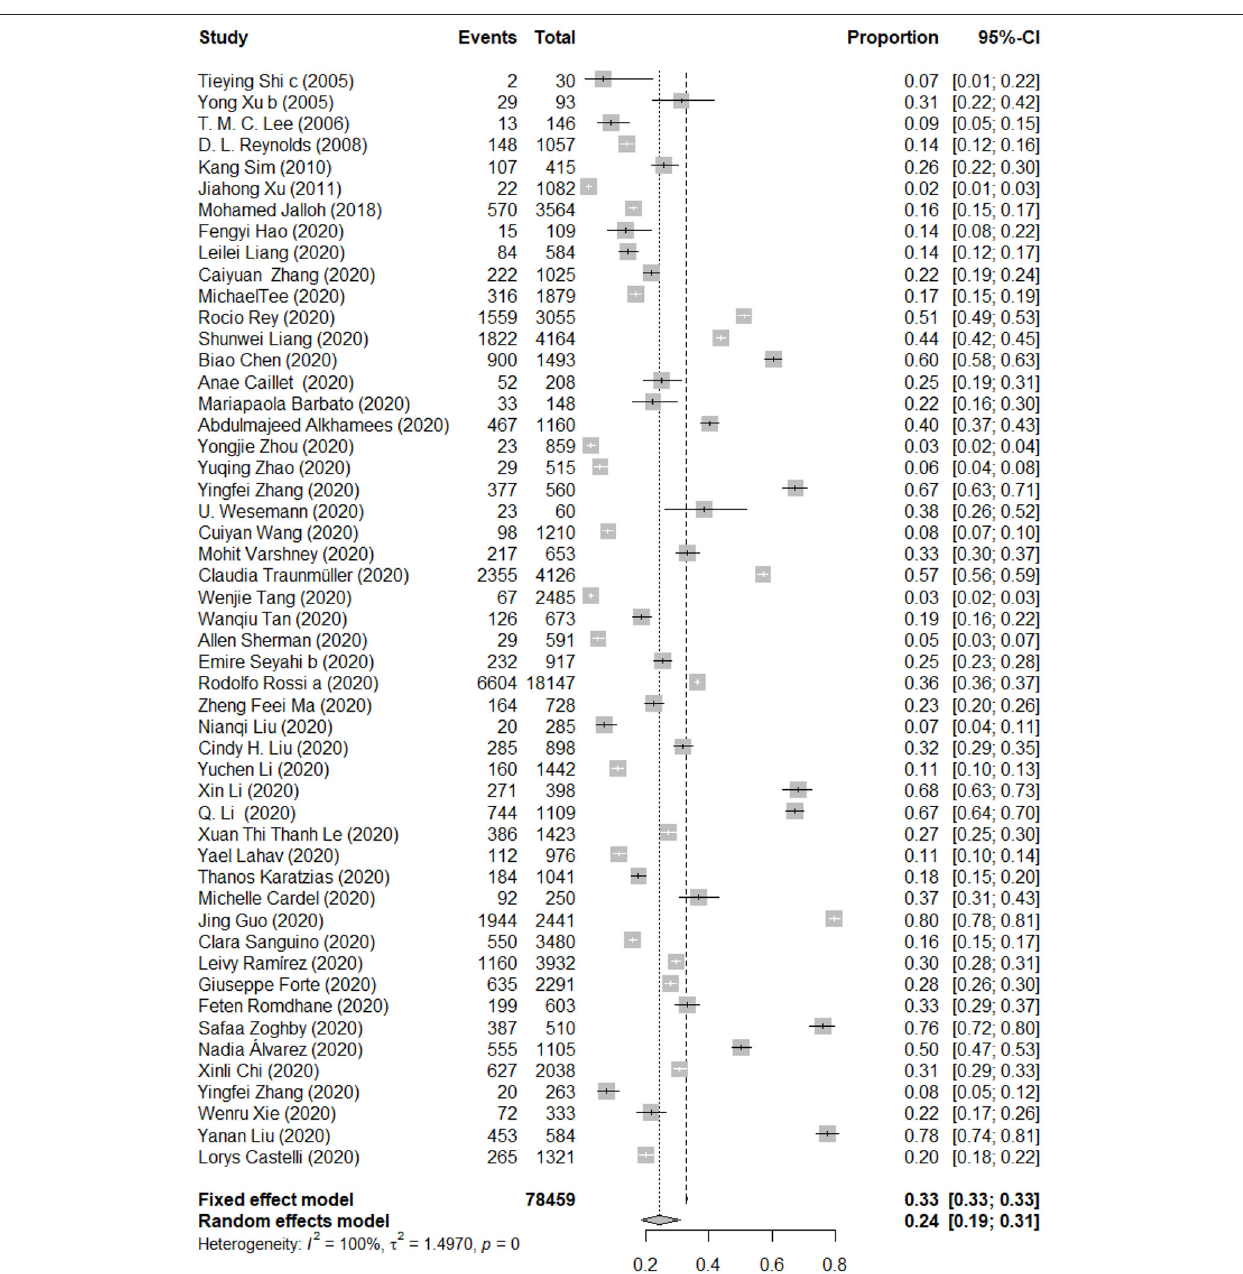
resulting from infectious disease outbreak was 25.04%, with a 95% CI of